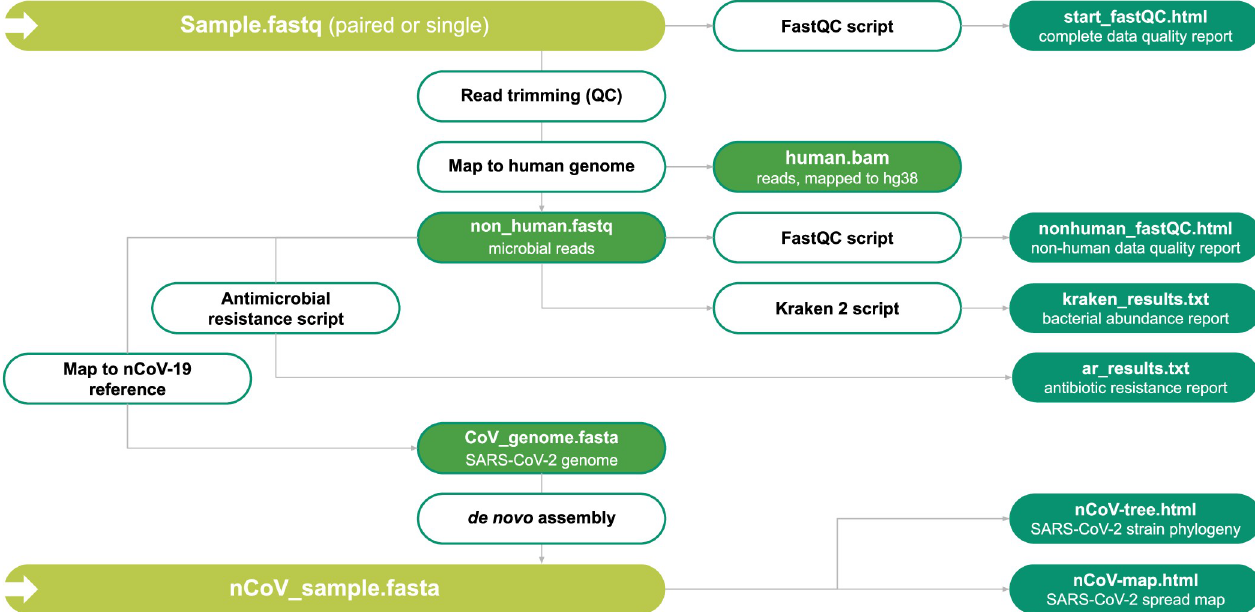
Fig 2. Metatranscriptome analysis for COVID-19 patients. The Schematic chart summarizes the data processing pipeline. Green boxes represent different data sets which are either used as an input or provided as output. White boxes represent the different scripts and software used to perform data processing. See main text for